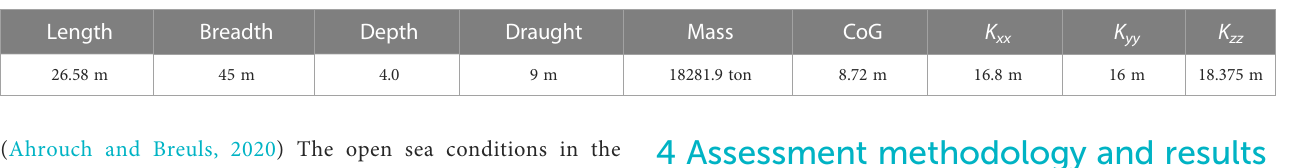
TABLE 3 The properties of attached WECs (Hüsken et al., 2019).